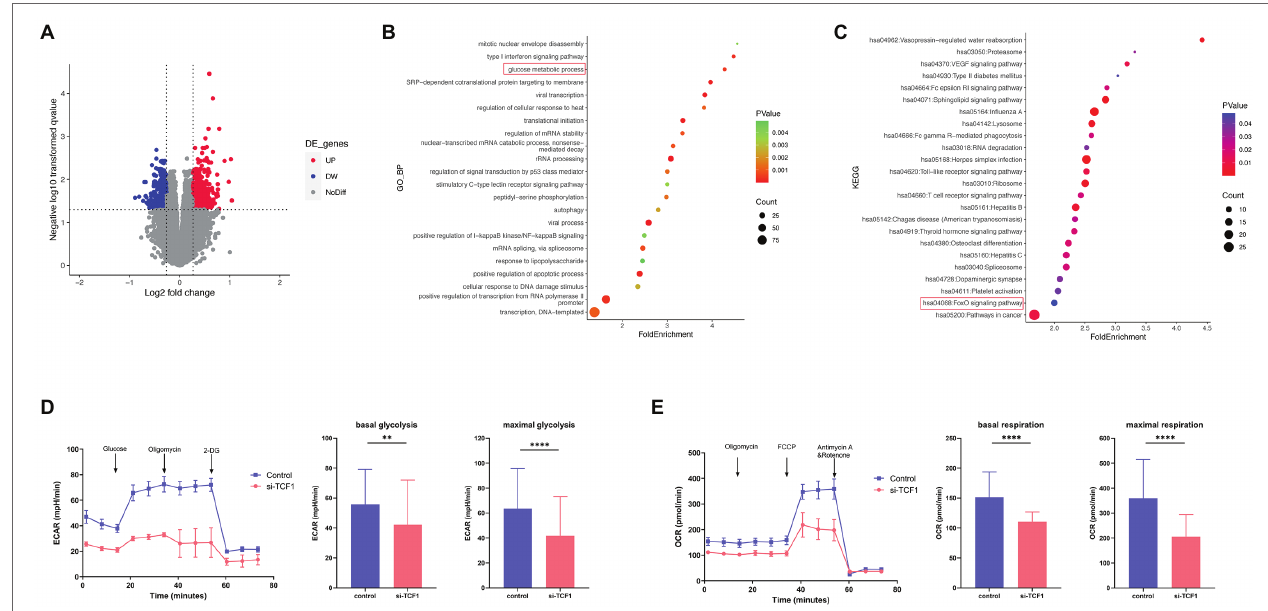
FIGURE 4 | T cell factor (TCF)1 regulates the glycolytic function of T cells. (A) The differentially expressed genes (DEGs) in the TCF1 high and TCF1 low groups. Red points mean upregulated, and blue points mean downregulated in TCF1 high groups. (B) Gene Ontology (GO) classification of DEGs from TCF1 high and TCF1 low groups. (C) KEGG pathways of DEGs from TCF1 high and TCF1 low groups. (D) ECAR of control or TCF1 knockdown T cells were subjected using Seahorse analysis. (2-deoxyglucose = 2-DG). Basal glycolysis and maximum glycolysis capacity were calculated and compared between control and si-TCF1 group by Paired t